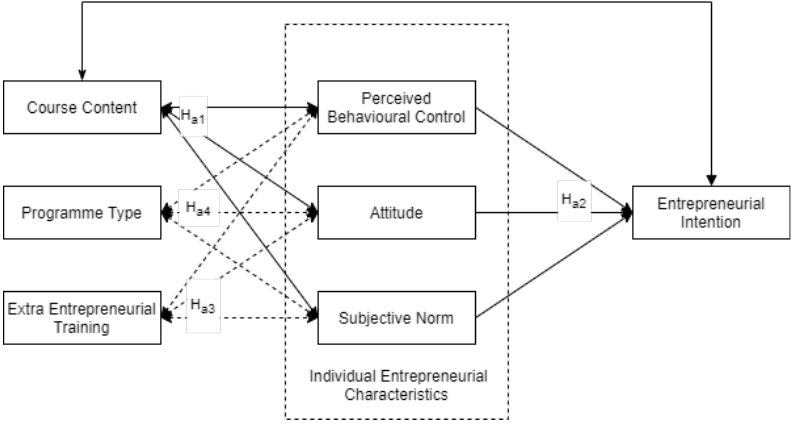
Figure 1: Conceptual Framework of the Study; Source: Author’s Conceptions based on Ajzen’s (1991) TPB A The paths shown by directional arrows indicate casual effect between variables whereas two-way directional arrows represent relationships of differences, broken arrow indicate differences. These paths between variables are developed on theoretical support which also gives rise to the hypotheses tested in this